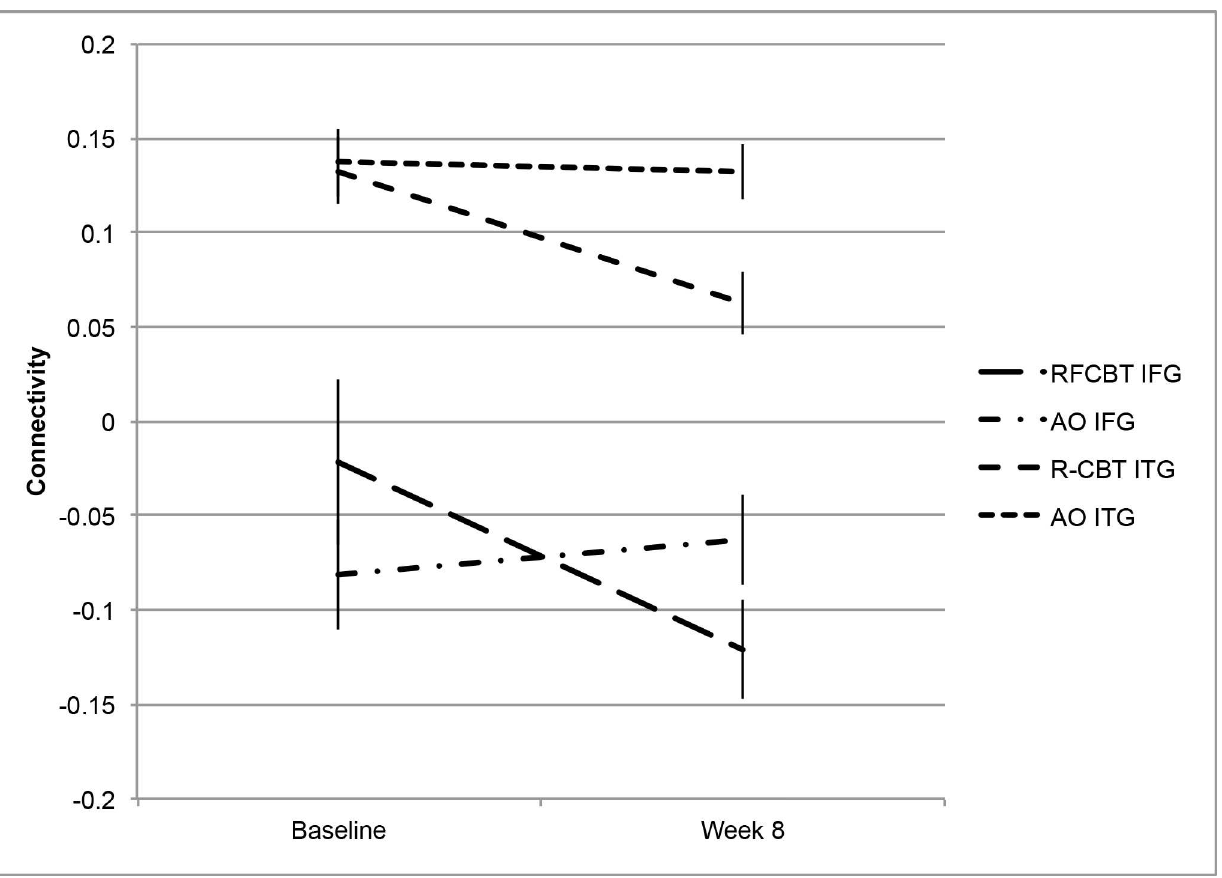
Fig 4. Change in connectivity across eight weeks from the left posterior cingulate seed to the right inferior frontal gyrus and right inferior temporal gyrus. Changein extracted connectivityvalues at baselineand week eight for the Rumination-focused CBT (RFCBT) and Assessment Only (AO groups) betweenthe left posterior cingulateseed and right inferior frontal gyrus (IFG) and right inferior temporal gyrus